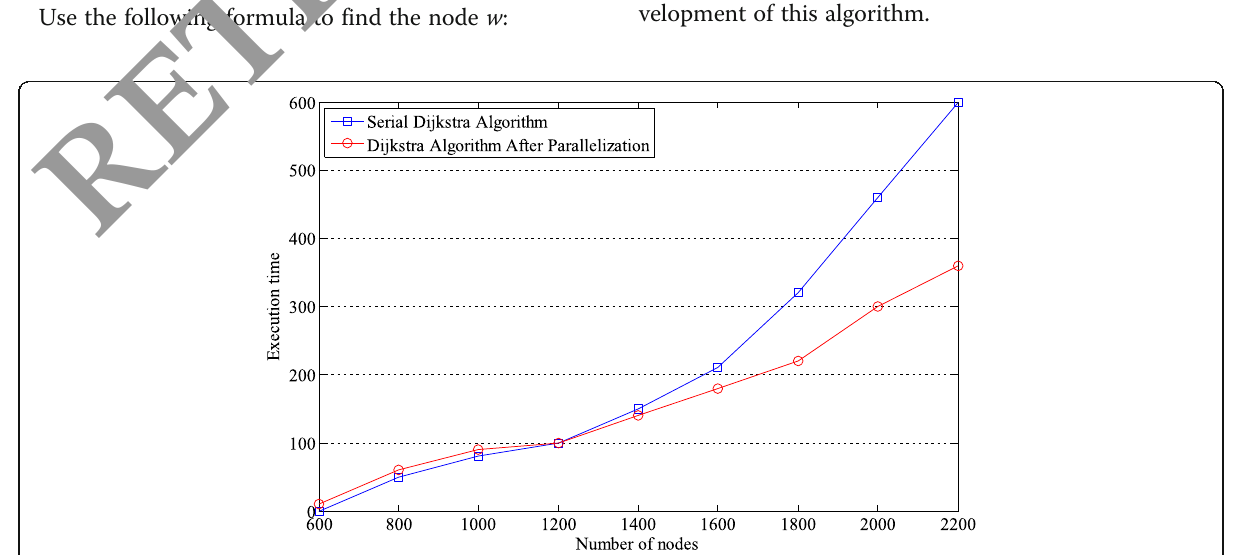
Fig. 4 Comparison of parallel Dijkstra algorithm and serial Dijkstra